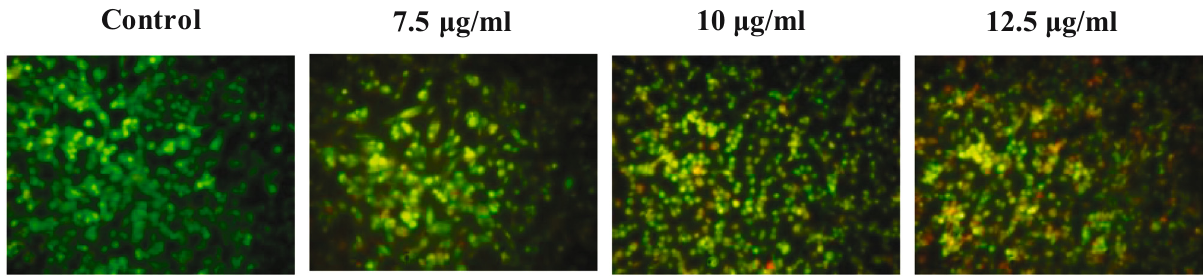
Figure 8: Induction in apoptosis as a result of ZnO NPs ’ treatment in MDA - MB - 231